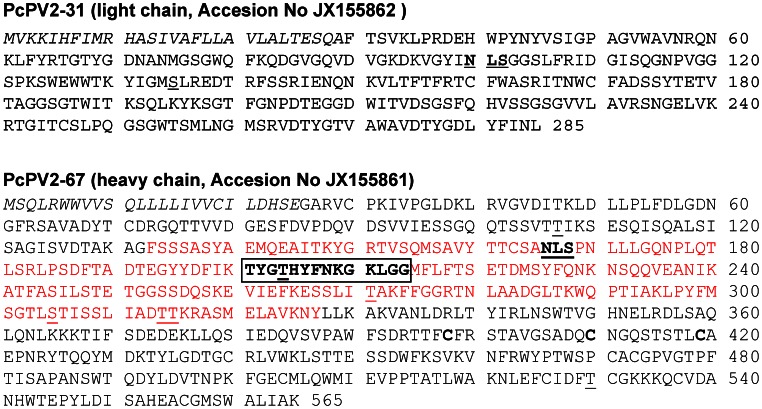
Deduced aminoacid sequences of light (A) and heavy (B) PcPV2 subunits.The putative signal sequences are in italics, MACPF domain is marked in red and MACPF signature is boxed. Potential phosphorylation sites are underlined, and potential glycosylation sites are underlined and in bold.